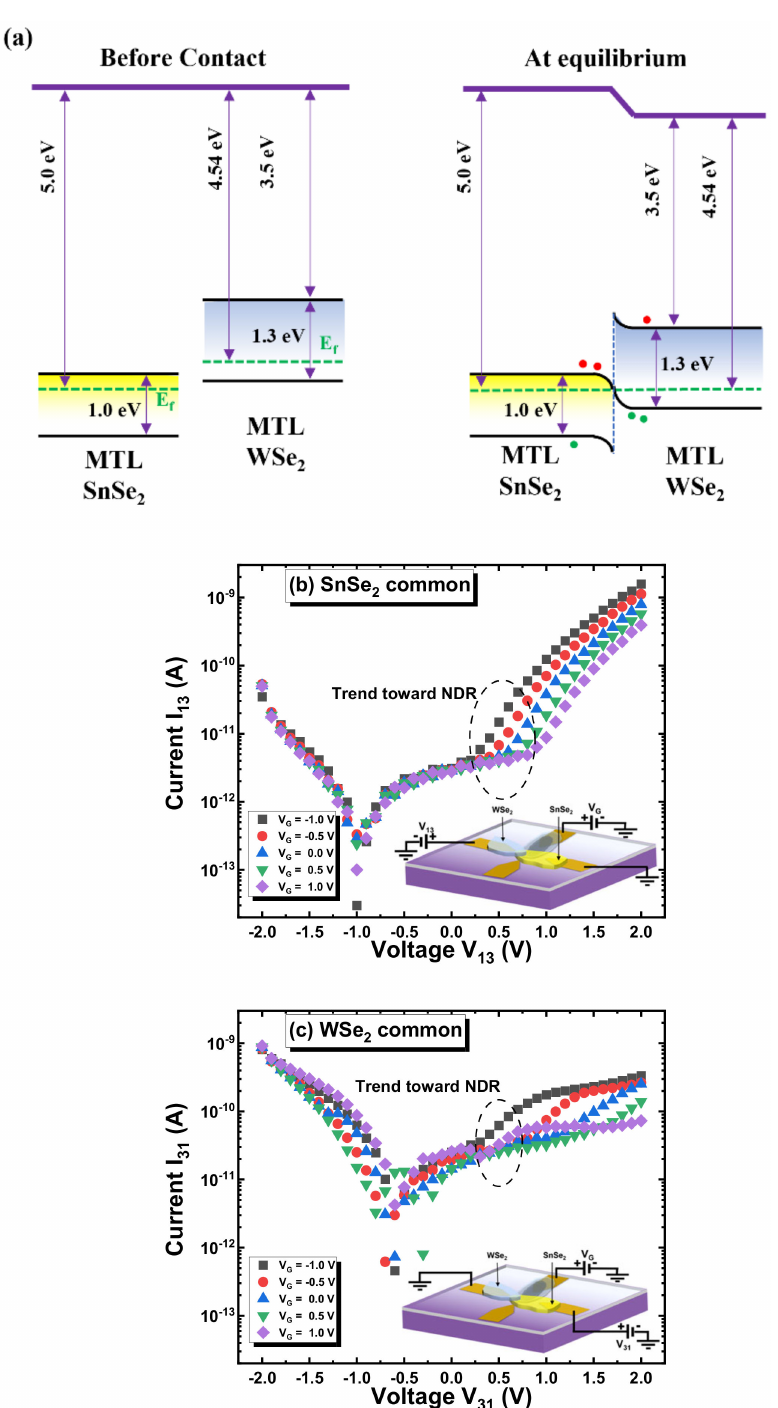
Figure 5. ( a ) Energy band diagram of p-WSe 2 / n-SnSe 2 heterostructure in the longitudinal direction. I–V curves in longitudinal directions when ( b ) SnSe 2 and ( c ) Wse 2 are used as common